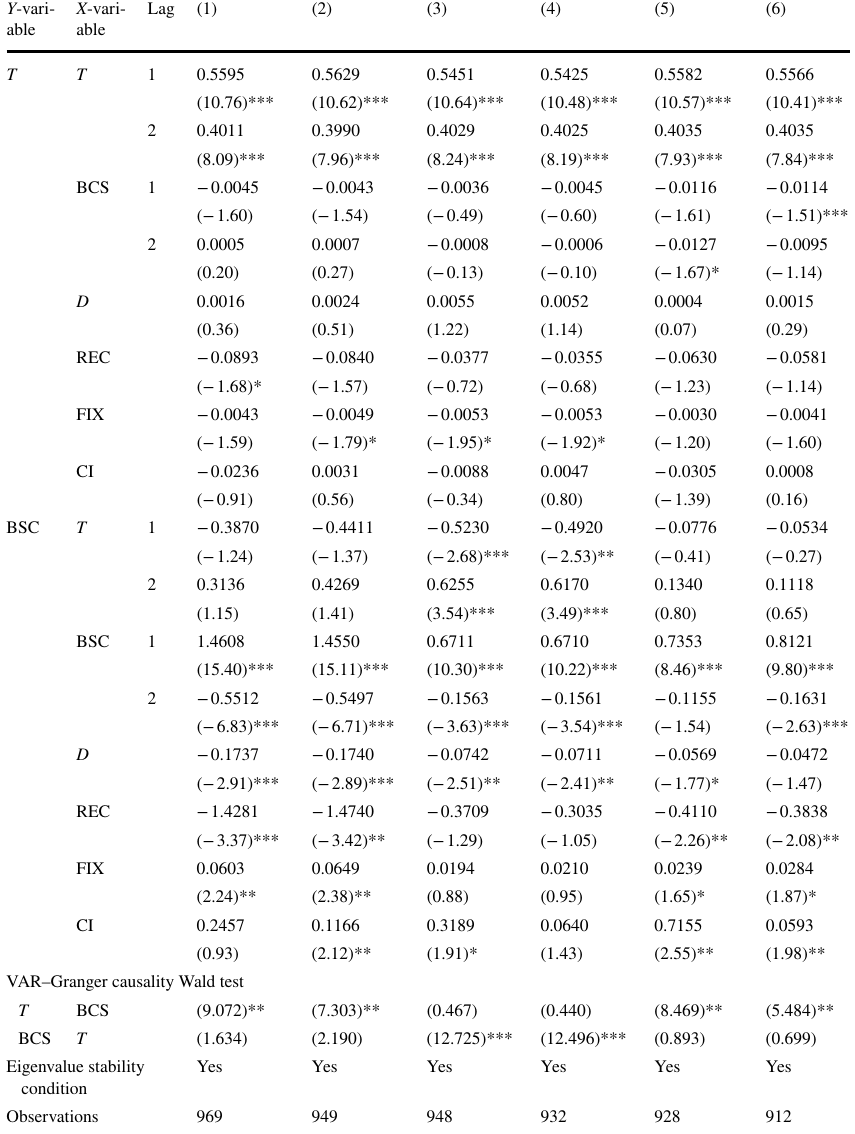
Table 5 PVAR estimation results. Source : Own